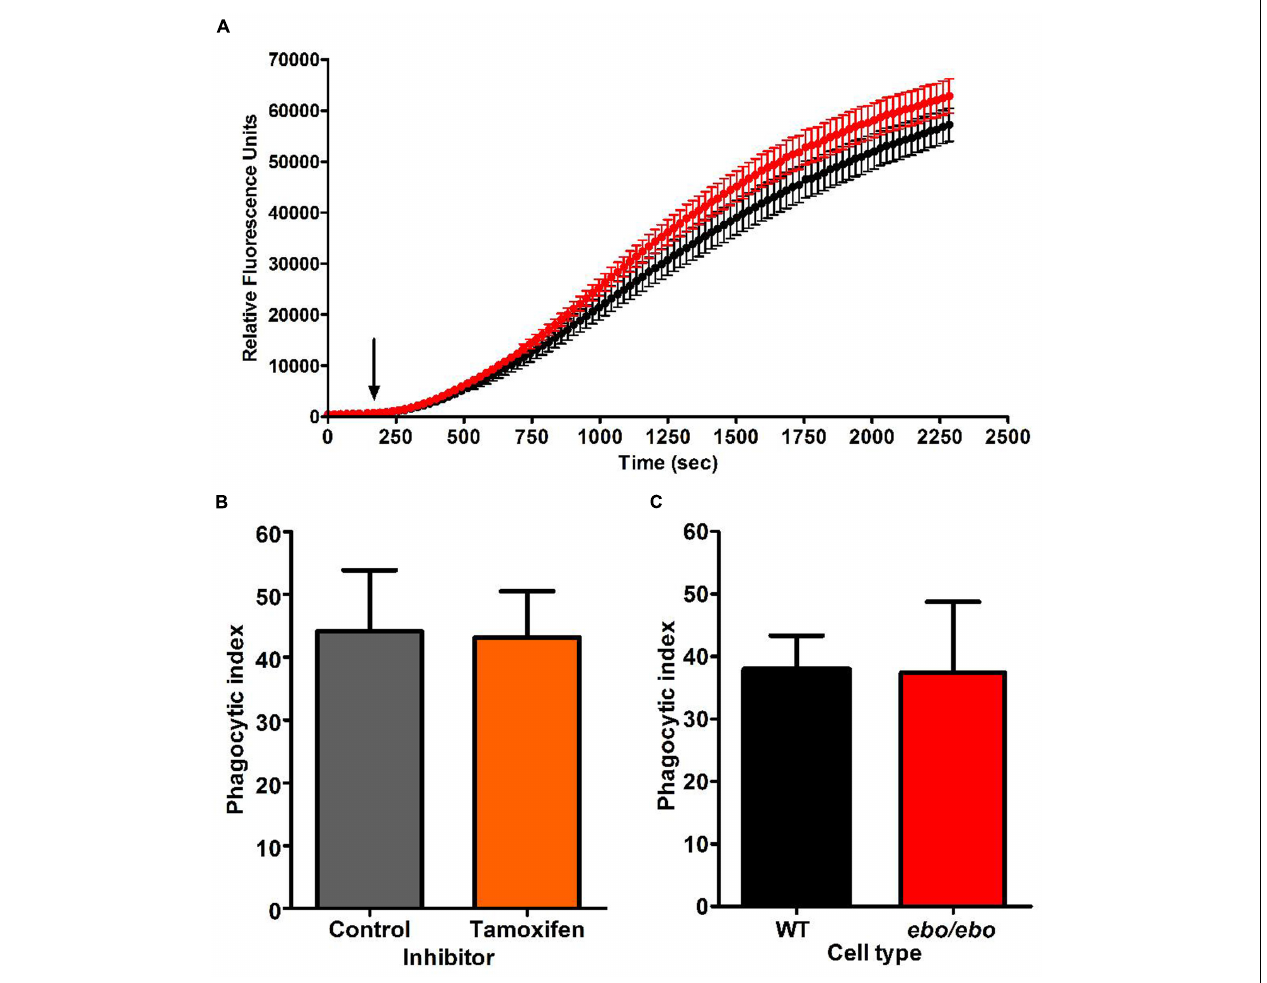
FIGURE 11 | (A) H 2 O 2 production by PMA stimulated WT (black trace) and ebo/ebo (red trace) neutrophils. The mean ± SEM is displayed from two independent experiments involving triplicate measures. The arrow marks the timing of PMA injection. (B) Tamoxifen (10 µ M) does not affect the phagocytosis of opsonised Candida ( n = 2, ± SEM) as measured by phagocytic index ( Table 1 ) in human neutrophils. (C) There is no difference in the phagocytosis by ebo/ebo neutrophils compared to WT neutrophils ( n = 3, ±